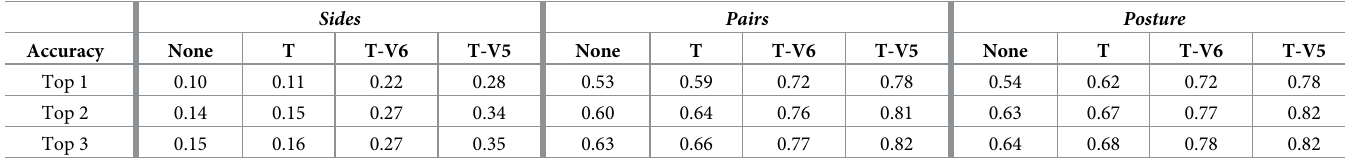
Table 4. Seeding posterior pair identities enabled more accurate posture identification. Top accuracies are reported across all samples on each row; each simulation had a four hour maximum runtime. Spanning columns specify which model was used while subcolumns under each model list which pairs were given as seeds prior